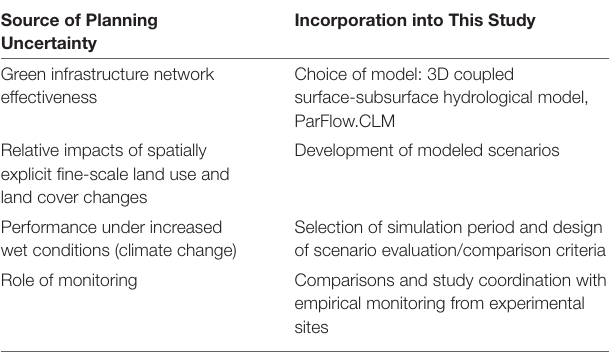
TABLE 1 | Sources of planning uncertainty and incorporation in this